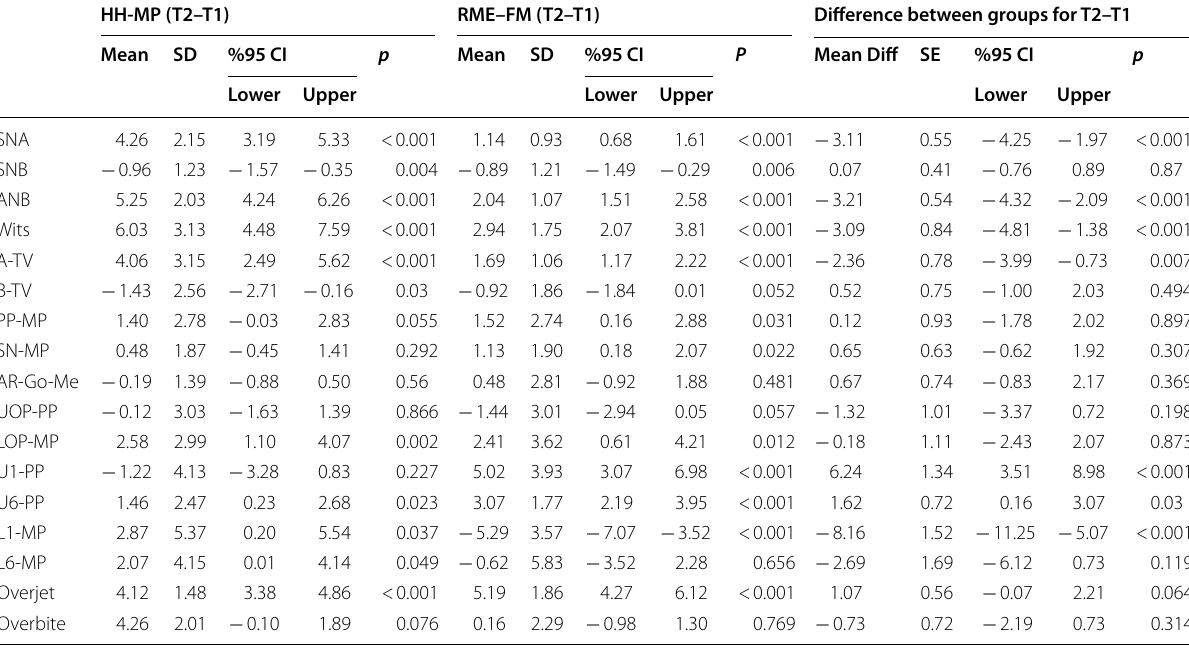
Table 4 Treatment changes and comparisons within and between